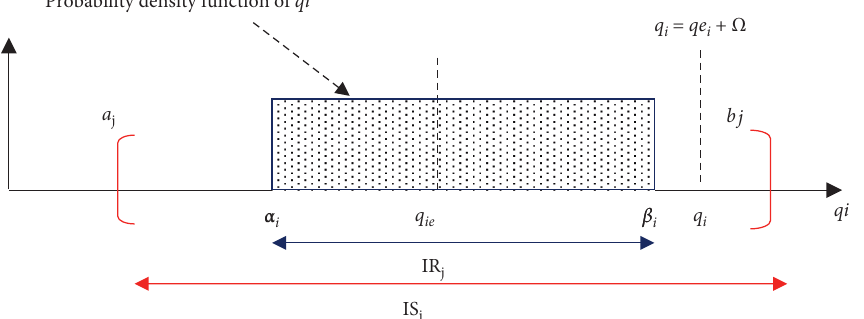
Figure 8: Static and dynamical intervals of place p